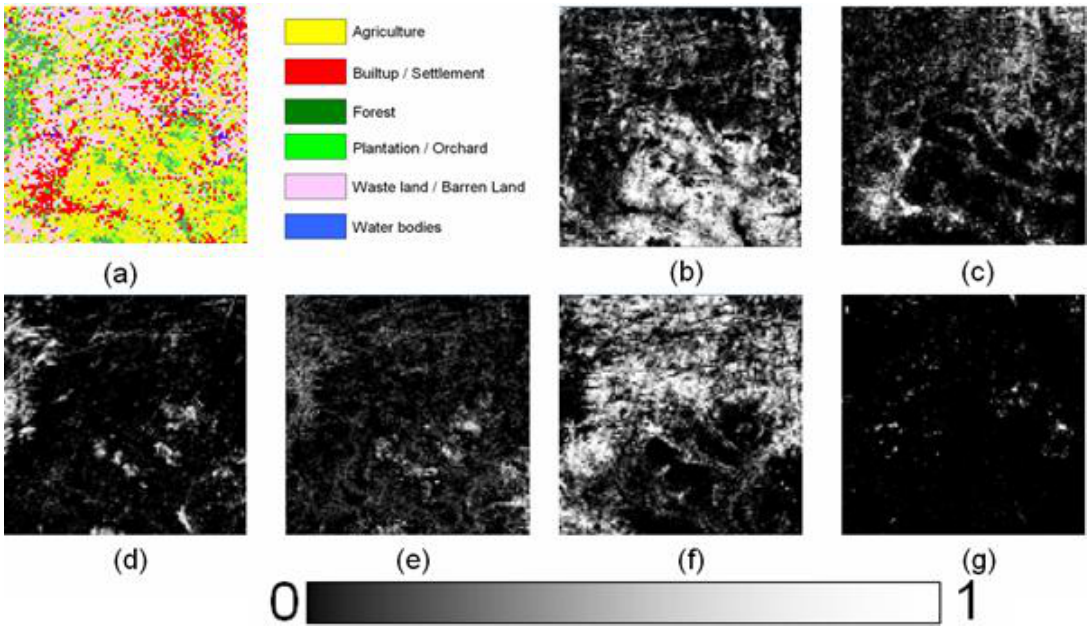
Figure 11. ( a )LISS-III classified map resampled to 100 × 100 pixels. Abundance maps for ( b ) agriculture; ( c ) built-up/settlement; ( d ) forest; ( e ) plantation/orchard; ( f ) wasteland; ( g ) water bodies obtained from HMM.